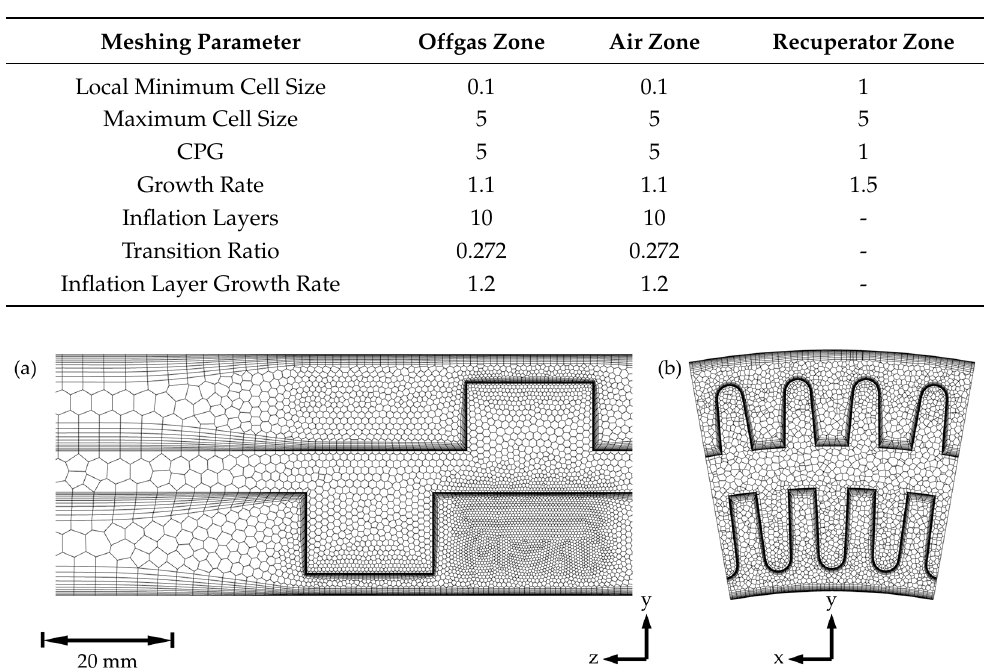
Figure 7. Mesh resolution in an axial cross-section ( a ) and radial cross-section ( b ).